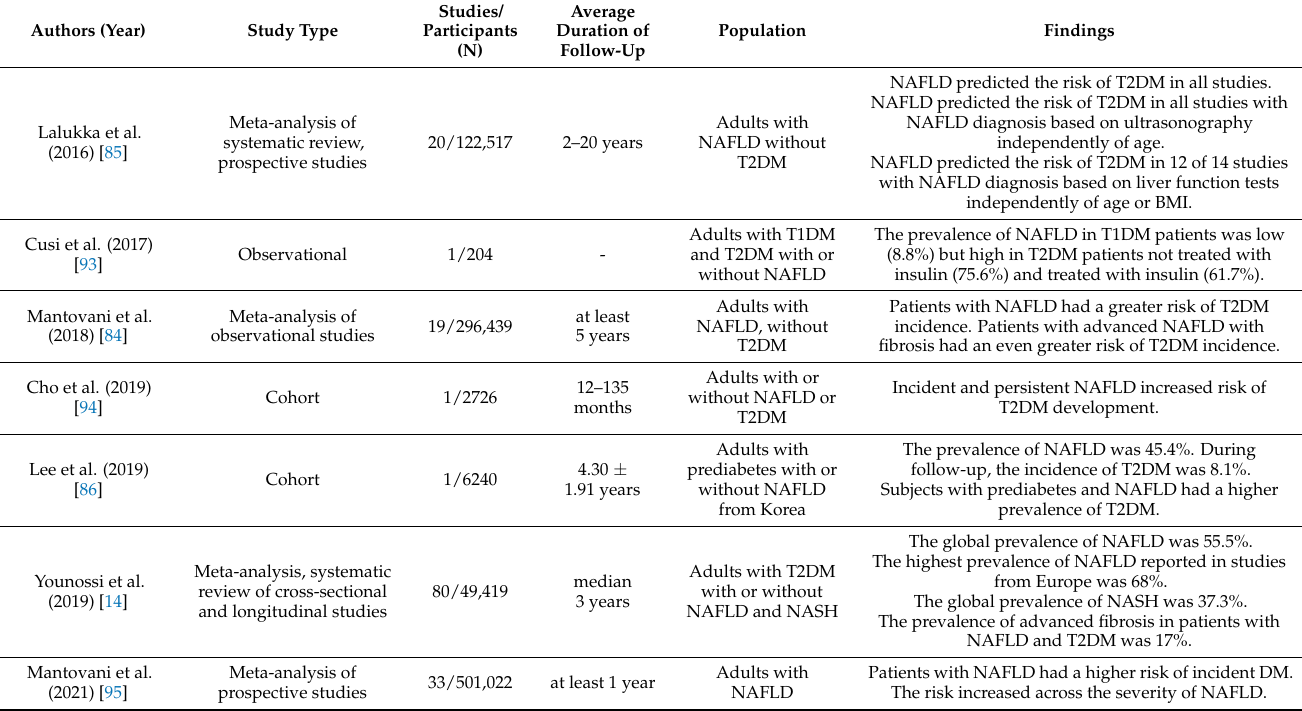
Table 4. NAFLD and